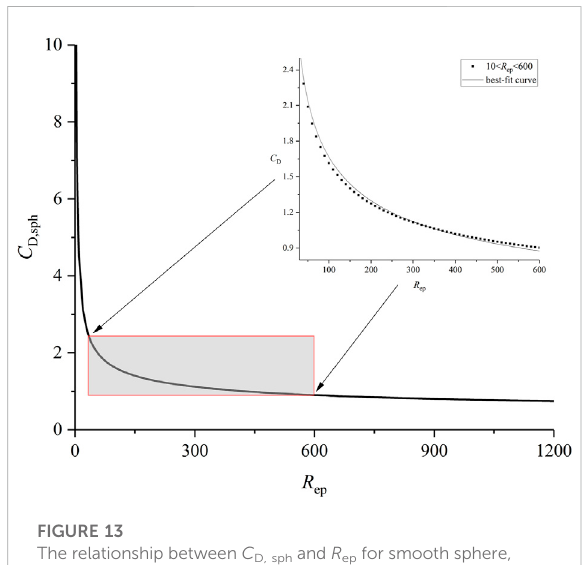
FIGURE 12 Comparisons between measured and calculated C D for present and other related studies.